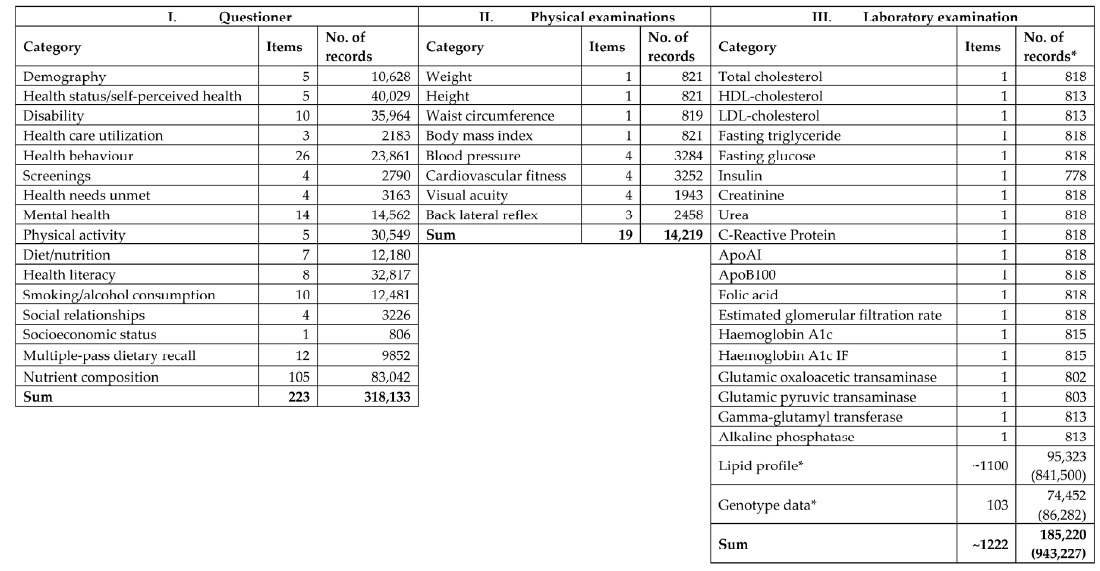
Figure 2. Content of the database by three pillars of the survey. *: available data (expected data).